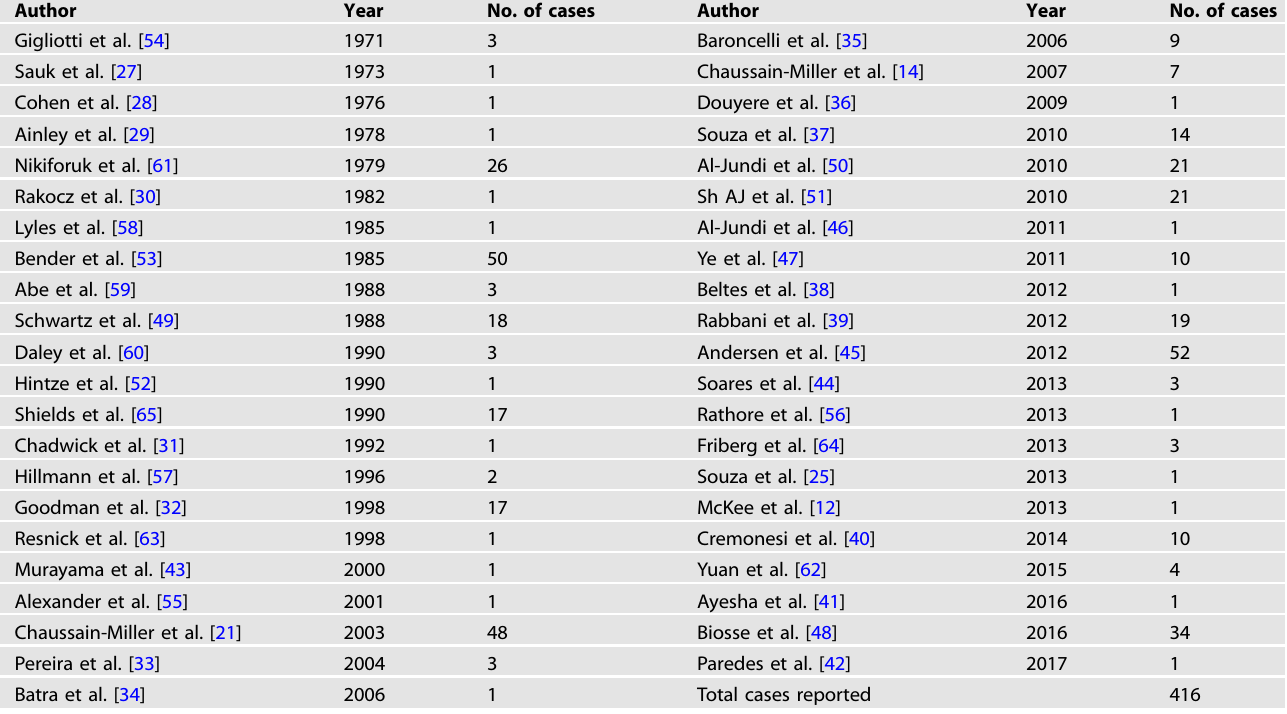
Table 1. Number of reported cases of hypophosphatemic rickets with dental